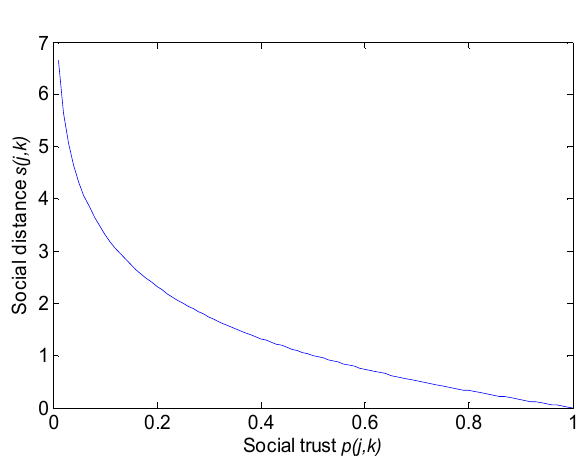
Figure 12. Dependence between social distance and social